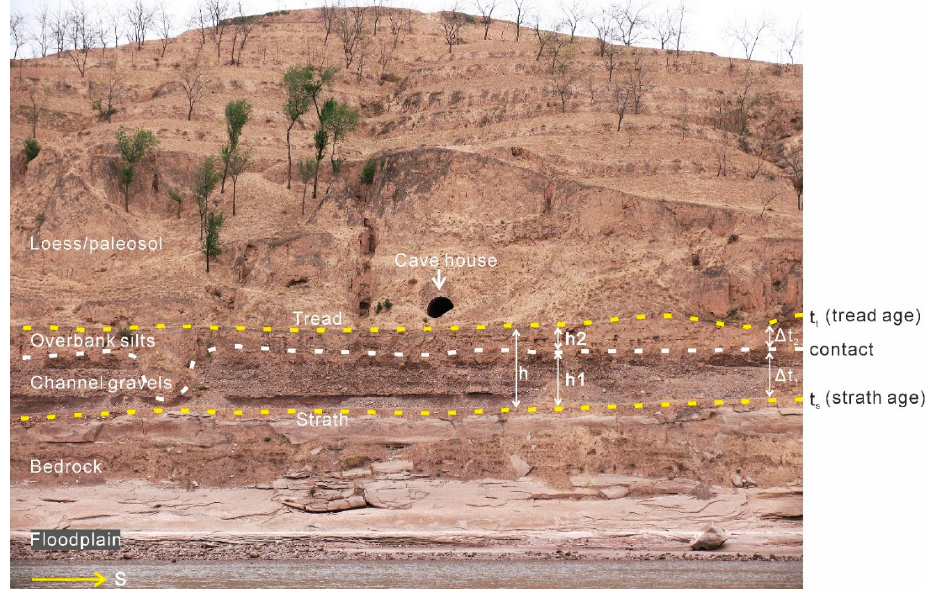
Figure 9. Photograph of an exposure in the Heiyukou area showing the lithostratigraphic units of a fluvial terrace of the Yellow River (flow south (S)) and the boundaries between the units. It also shows the difference ( ∆ ) between the formation ages (t s and t t ) of the strath, and the tread varies from terrace to terrace. h, h1 and h2 represent, respectively, the thickness of the terrace deposits, channel gravels and overbank sediments, h = h1 + h2 (see text for details). The upper overbank facies may be in unconformable contact with underlying channel facies because of erosion or depositional hiatus. The gate (about 2-m-wide) of a cave house excavated in loess provides a scale.